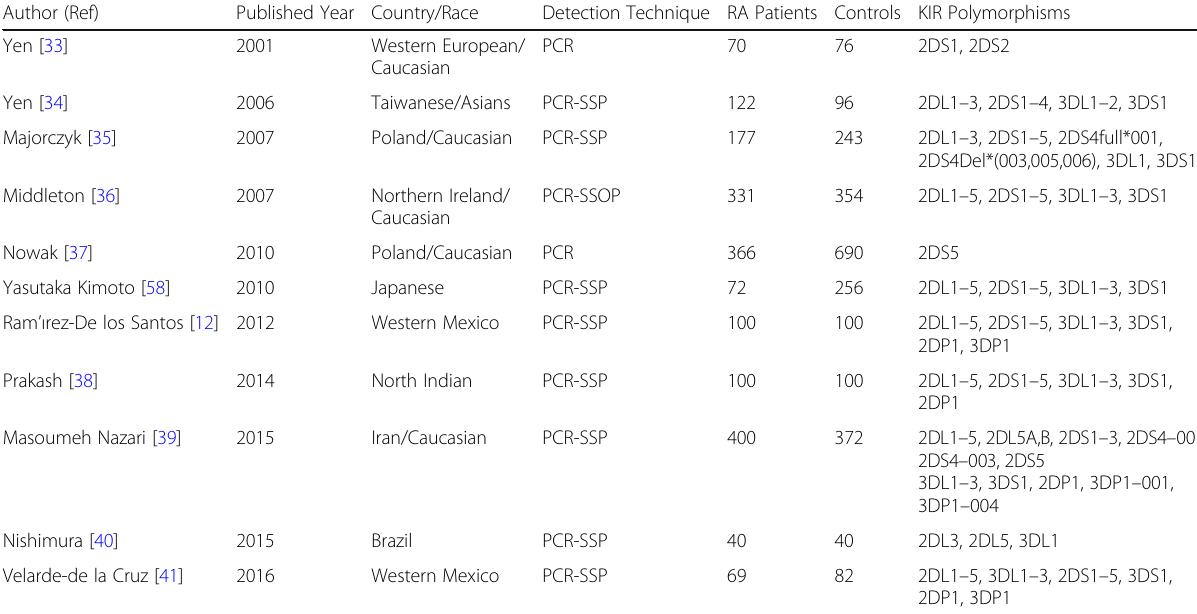
Table 1 Characteristics of the included studies in